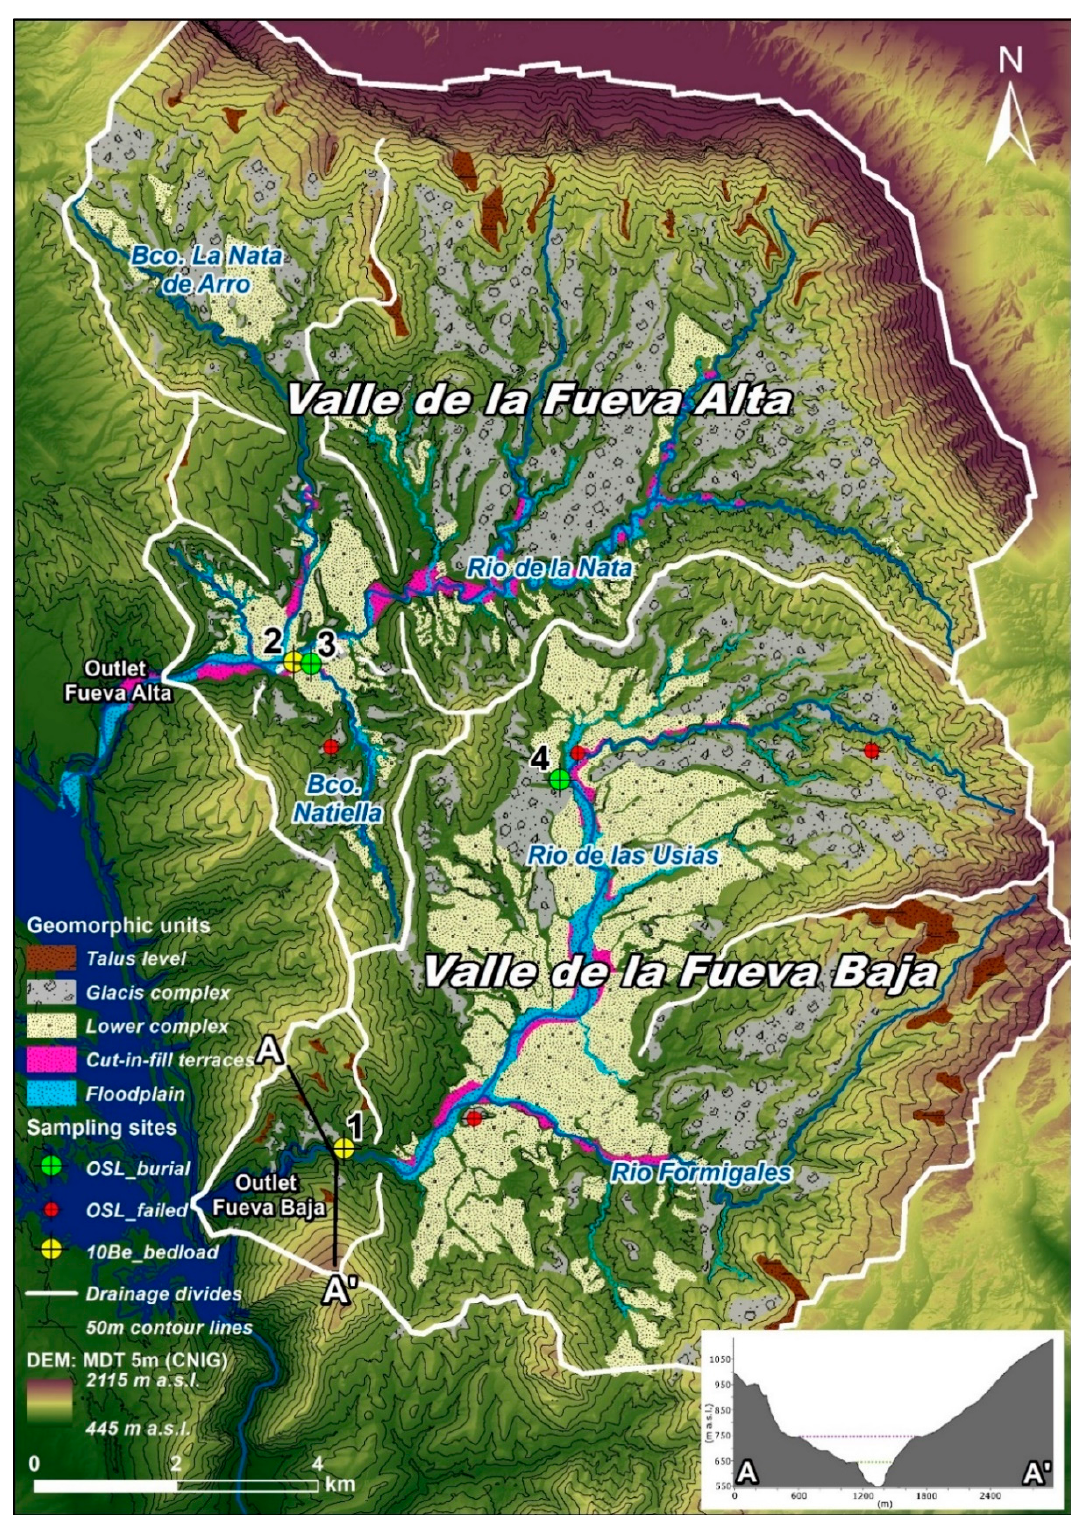
Figure 2. Geomorphological map of the study area showing the morphogenetic units of the Valle de la Fueva, locations of TCN / OSL sampling sites, and the main tributaries and drainage divides. Inset: Topographic cross-section (A–A’) of the Fueva Baja outlet canyon.